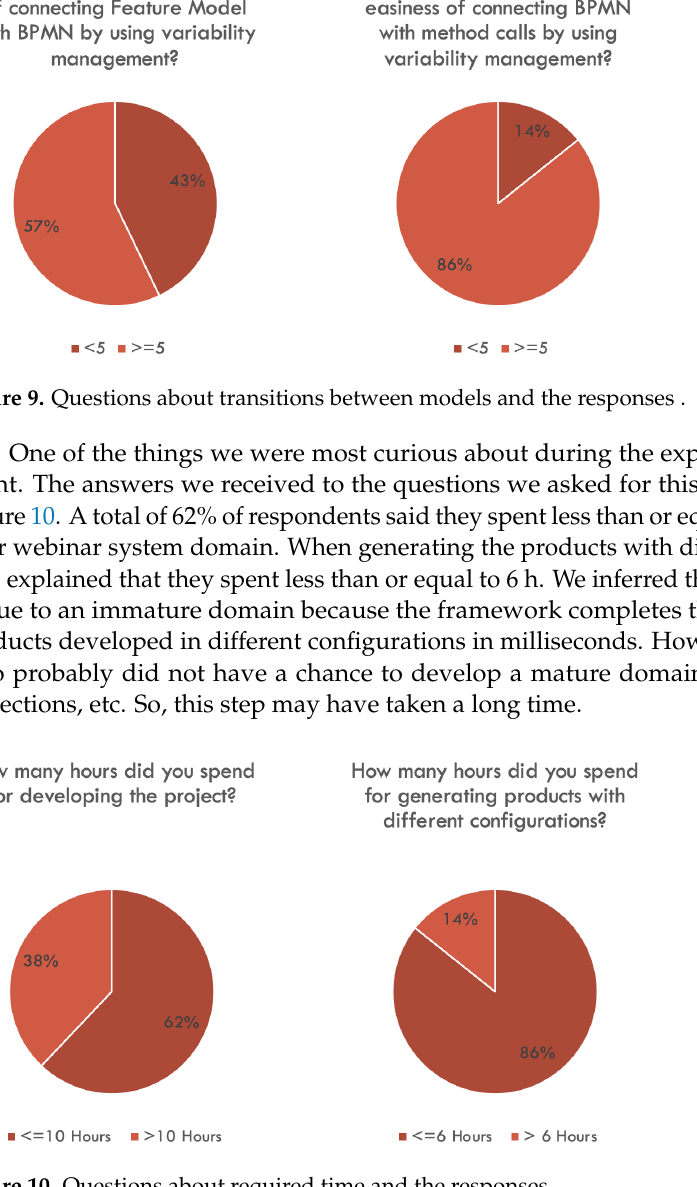
Figure 10. Questions about required time and the